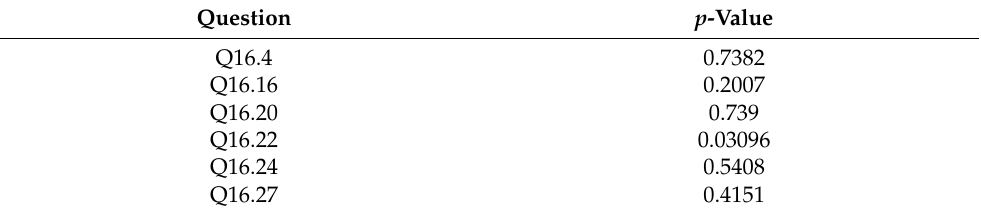
Table 4. Wilcoxon test between experimental and control groups.